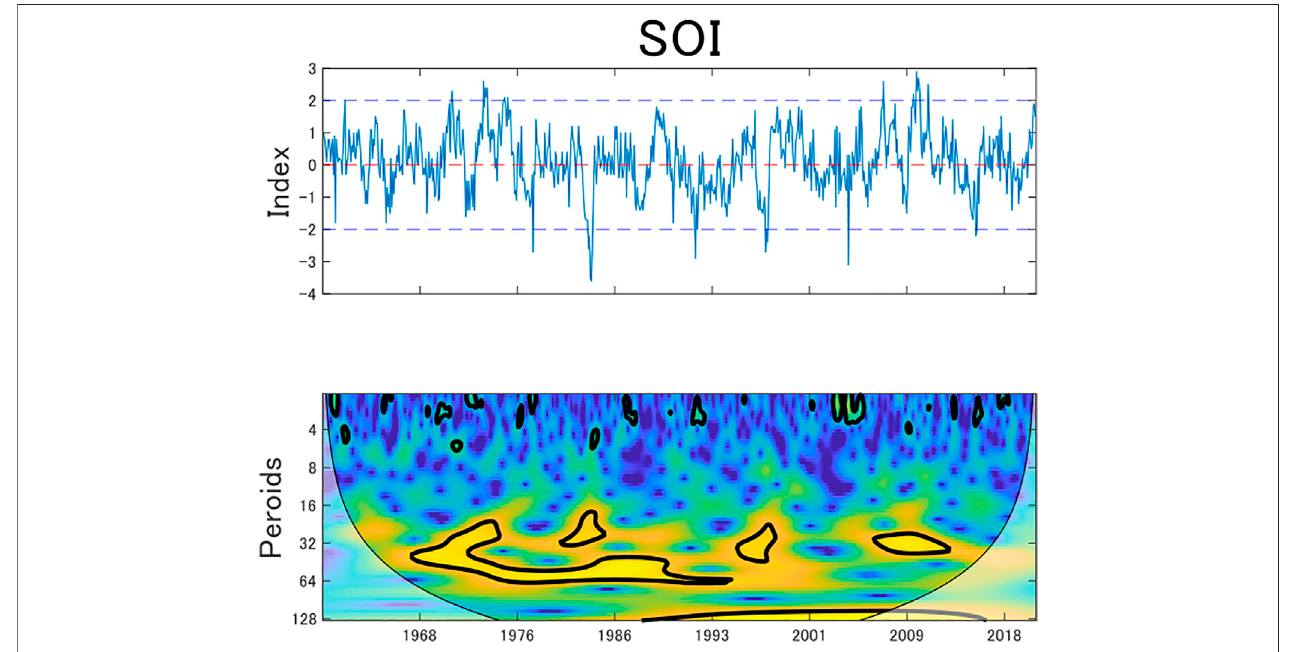
FIGURE2| SOI fi gurefromtoptobottomarethetimeseriesoftheSouthernOscillationIndexatthetopanditswaveletpowerspectrumatthebottom.Notes:The black contour in the wavelet power spectrum shows a 5% signi fi cance level estimated from the Monte Carlo simulations. The color code in the wavelet power spectrum shows the degree of local variance, ranging from blue (low variance) to yellow (high variance). The bold line in the wavelet power spectrum shows the edge